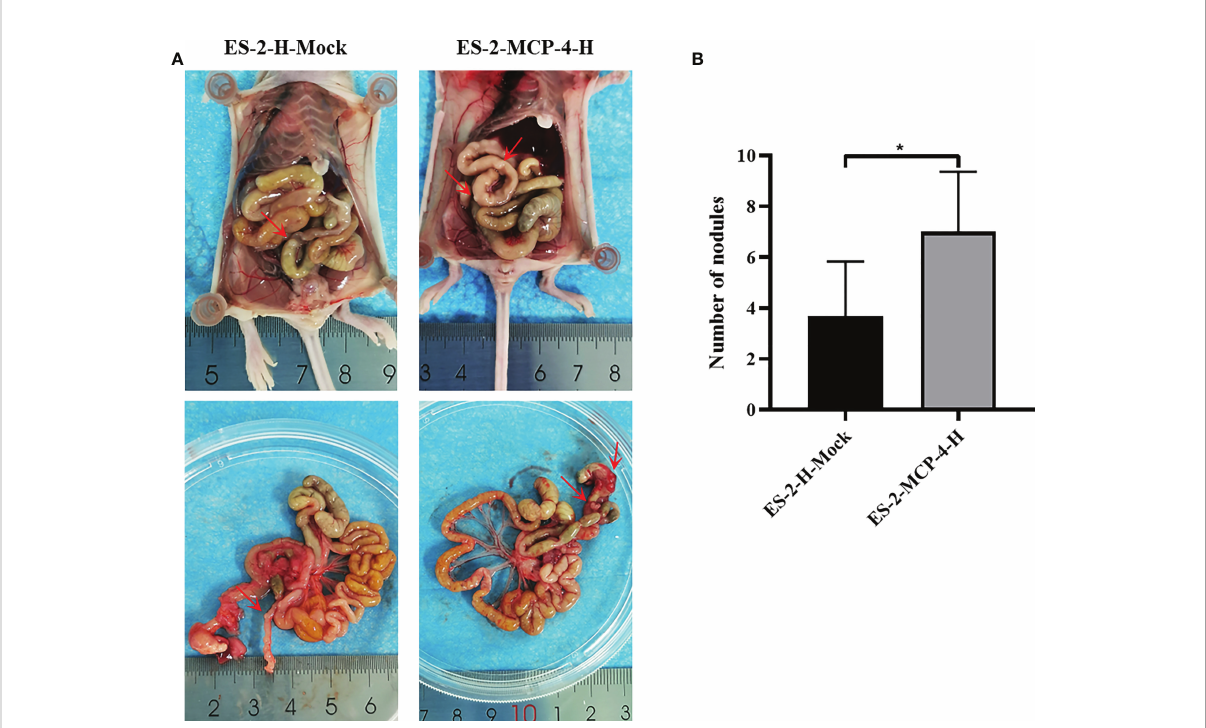
FIGURE 6 MCP-4 promotes metastasis in a nude mouse peritoneal xenograft tumor model. (A) After being sacri fi ced, dissemination of tumor in nude mice was assessed, and the metastasis nodules were marked by red arrows. (B) Average number of the peritoneal tumor nodules of each group were quanti fi ed (n = 6). Data are presented as mean ± SD. * P <